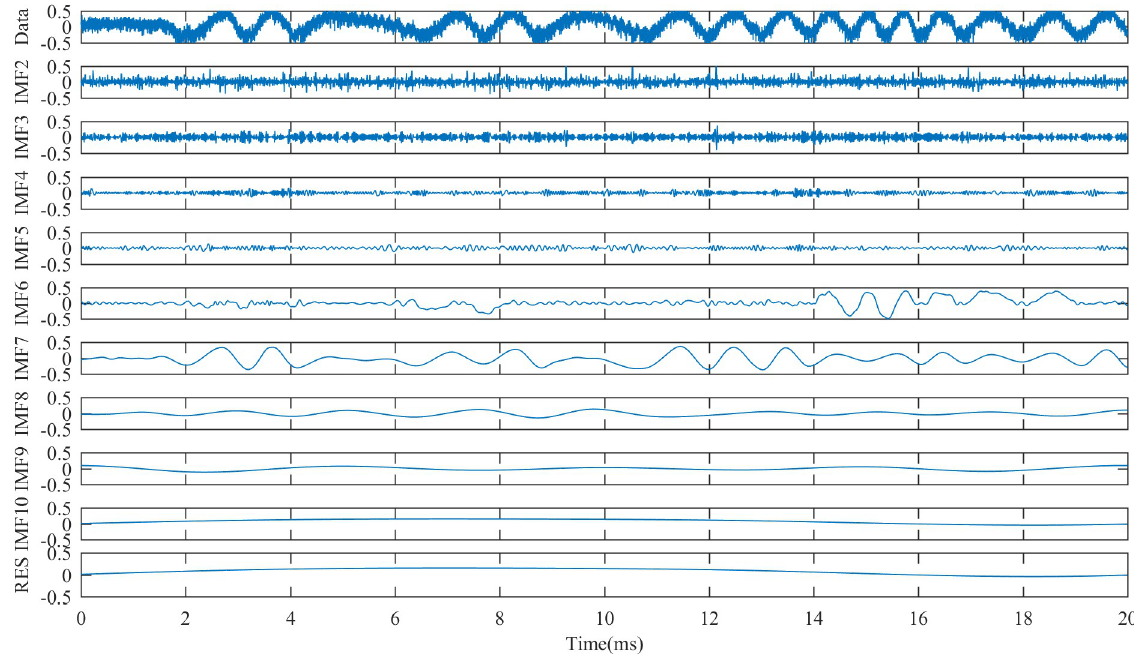
Fig 5. REMD of the input signal.